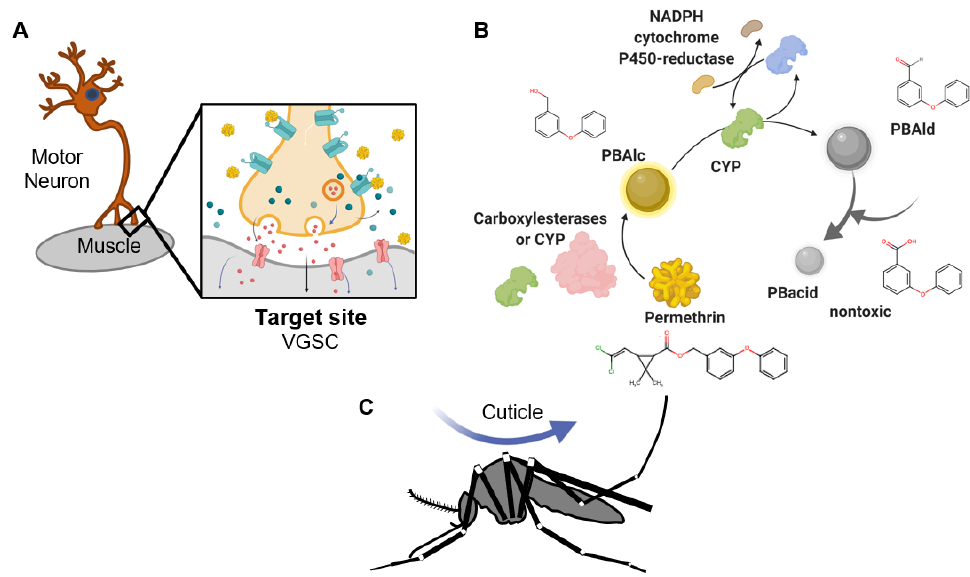
Figure 1. Three major pyrethroid resistance mechanisms. ( A ) At the target site, pyrethroid molecules (gold spheres) bind voltage-gated sodium channel (VGSC) (aqua) to depolarize motoneurons and cause paralysis. Target site mutations were subsequently selected in resistant populations. ( B ) Bio- chemical effectors detoxify pyrethroids to nontoxic forms, e.g., phenoxybenzoic acid (PBAc), that are excreted (Figure 2). Pyrethroid is indicated in gold spheres; cytochrome P450 (CYP) proteins are indicated in green; carboxylesterases (COEs) are indicated in pink; rejuvenation of CYP (from blue oxidized to reduced green form) by nicotinamide adenine dinucleotide phosphate (NADPH) cytochrome P450-reductase (CPR) [45]. ( C ) Cuticular thickening and/or modifications are also features of resistance. Figure prepared using Biorender, with permission (Biorender.com, accessed on 22 March 2021). Chemical structures were drawn using Marvin JS (v. 17.4.3, chemaxon.com, accessed on 22 March 2021).